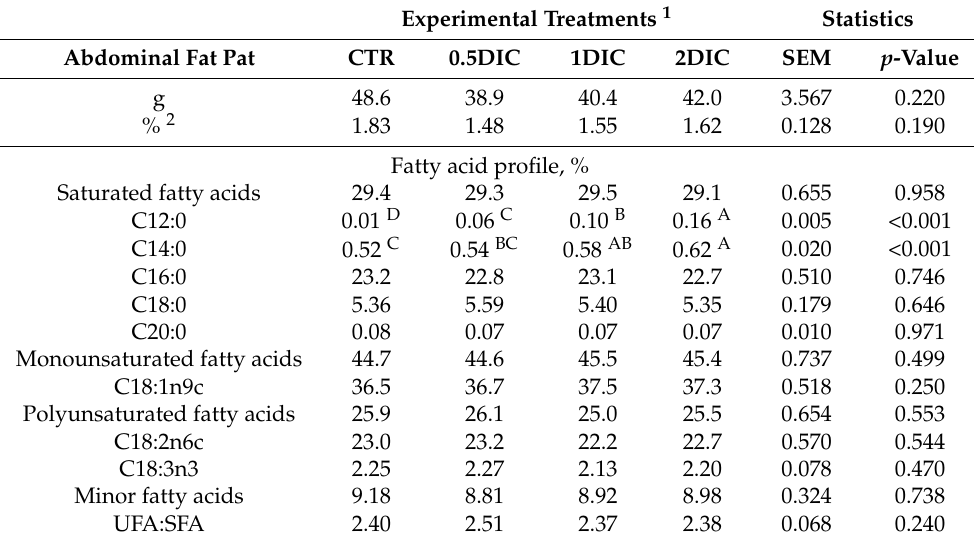
Table 6. Effects of dietary DIC supplementation level on abdominal fat pat and its fatty acid composi- tion in 44-day-old broiler chickens (Experiment 1).